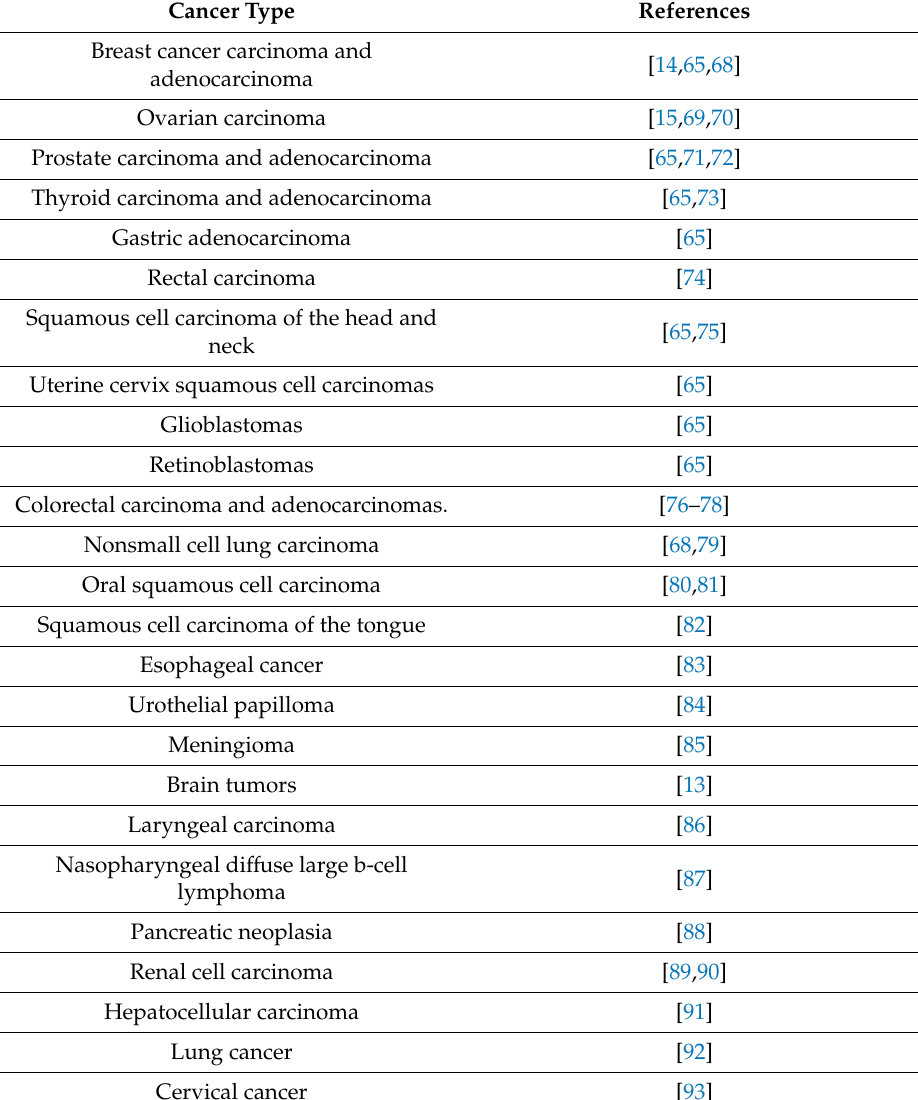
Table 1. Overexpression of GLUT1 in human